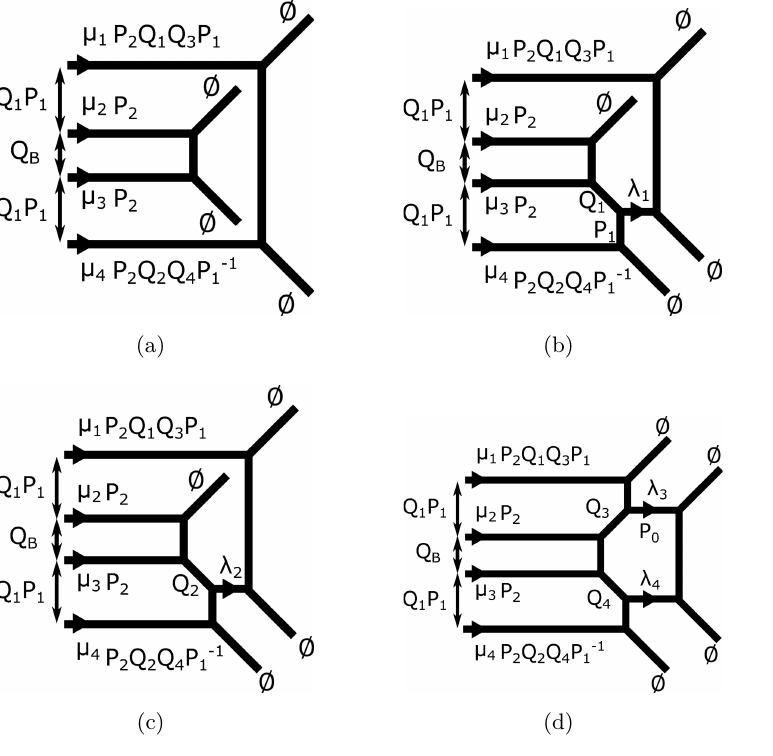
Figure 28. Assignment of Young diagrams ( µ 1 , µ 2 , µ 3 , µ 4 , λ 1 , λ 2 , λ 3 , λ 3 ) and Kähler parameters ( Q 1 , Q 2 , Q 3 , Q 3 , P 1 , P 2 , Q B ) for each of the four diagrams in figure 26.